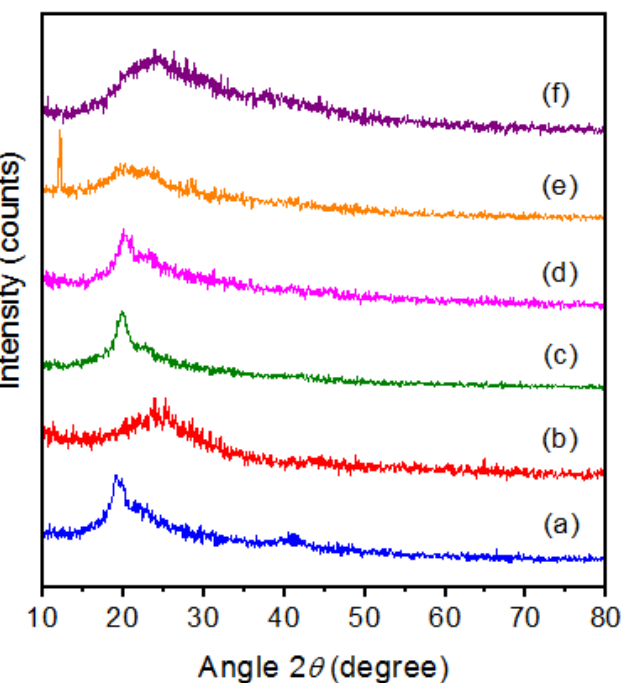
Figure 3. XRD patterns of ( a ) pure PVA, ( b ) PPy, and PVA/PPy/KI/I 2 electrolytes with various plasticizers (in wt%); ( c ) EC, ( d ) PC, ( e ) GBL, and ( f ) DBP. Table 1. Degree of crystallinity of the PVA/PPy/KI/I 2 electrolyte with different plasticizers.